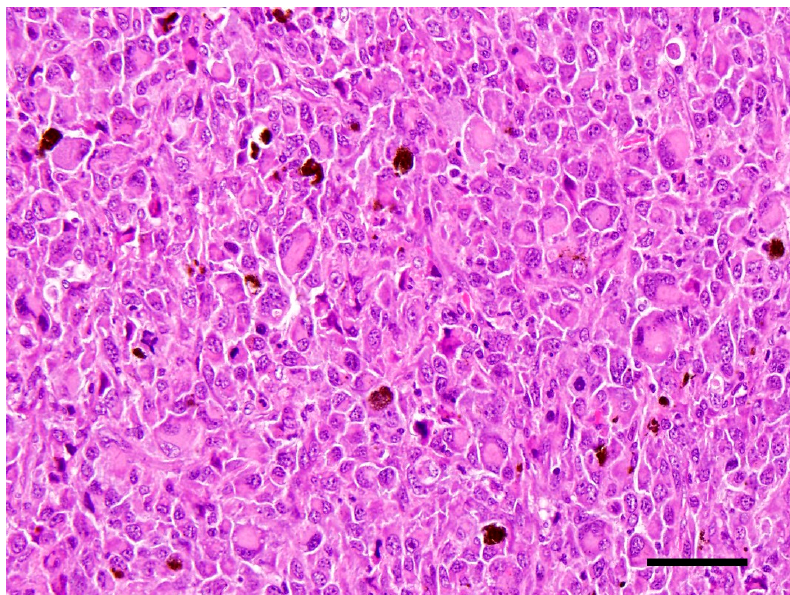
Figure 3. Neoplastic round cells in the eye. They displayed marked anisocytosis and anisokaryosis with moderate to abundant amounts of eosinophilic cytoplasm. Nuclei were singular to multiple and reniform to rounded nuclei with heterochromatin; H&E 40×; bar = 50 µm. The neoplastic cells expressed strong plasmalemmal staining for CD18 (Figure 4). The cells were weakly positive for MHC class II, and negative for CD3.